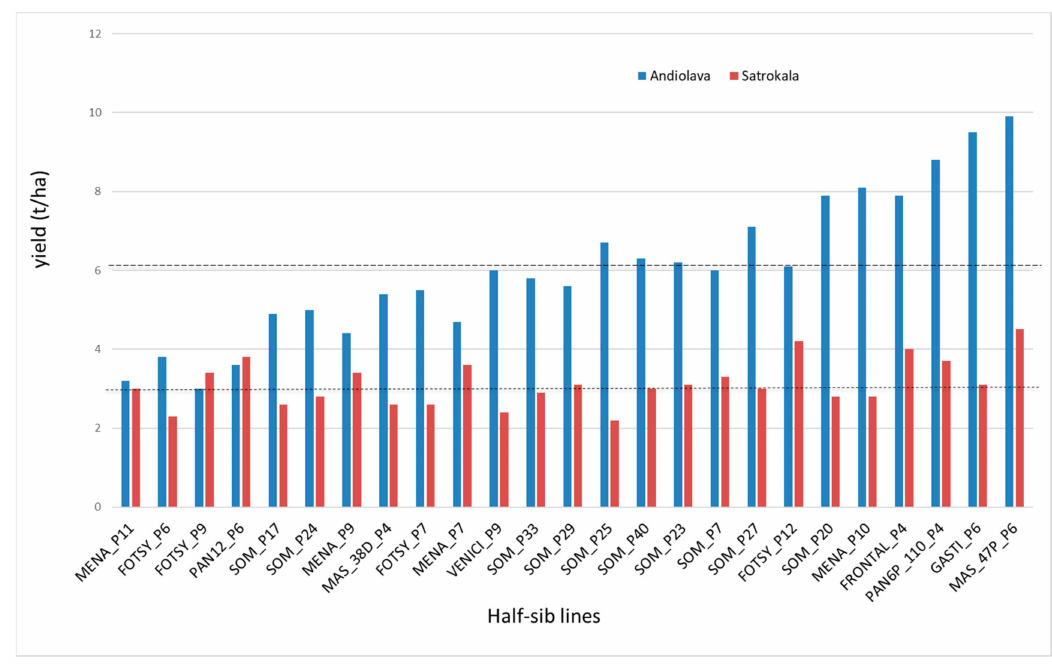
Figure 1. Half-sib progeny yields comparison in the two cultivation areas. Yields were calculated as plants plot yields and then referred to hectare. Dotted line represents the mean yield values obtained in Satrokala while the dashed lines the values of Andiolava. Table 2. Mean values of vegetative and production parameters for the half-sib progeny comparison (AS 2014–2015) and their BLUP predictors combined across